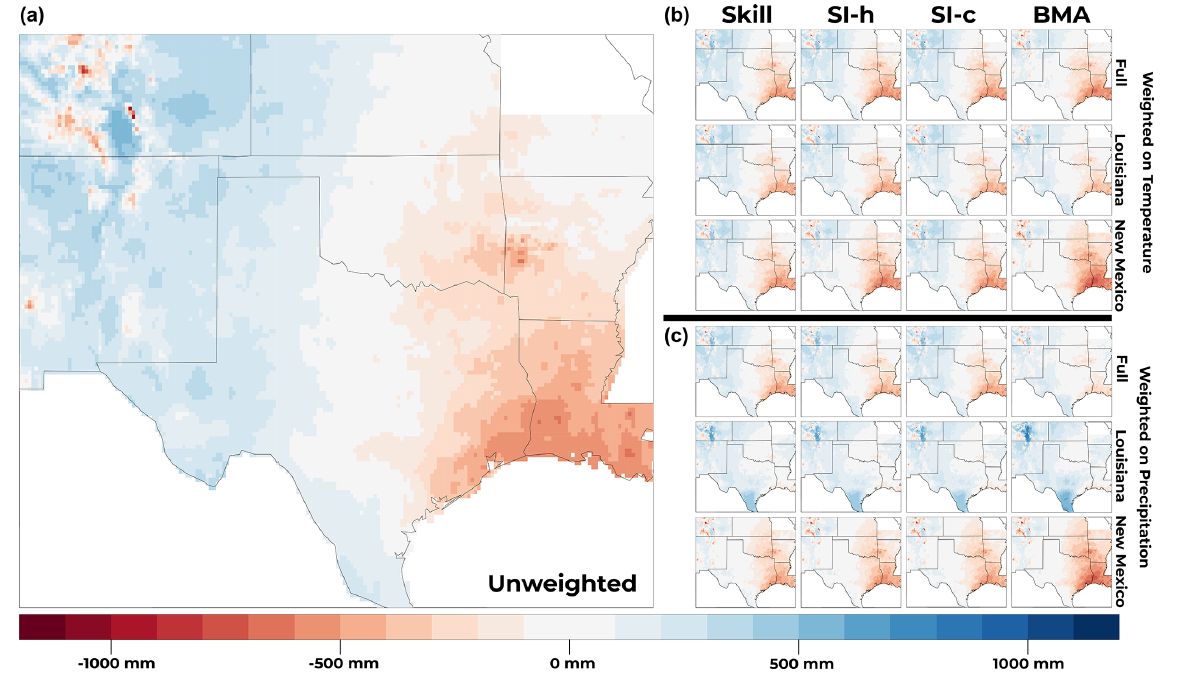
Figure 8. Bias of CMIP5 ensemble mean precipitation (1981–2005) from the unweighted ensemble (a) and each weighted ensemble mean (b, c) . On the right side, the columns from left to right are for the Skill, SI-h, SI-c, and BMA weighting schemes, respectively. The plots in panel (b) show the results for weights derived using temperature (tmax), and the plots in panel (c) show the results for weights derived using precipitation (pr). Within a group of 12 on the right-hand side, the top row is for weights derived using the full domain, the middle row is for weights derived using the Louisiana domain, and the bottom row is for weights derived using the New Mexico